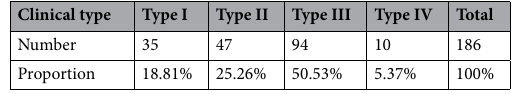
Table 2. Results of genetic diagnosis of SMA patients.